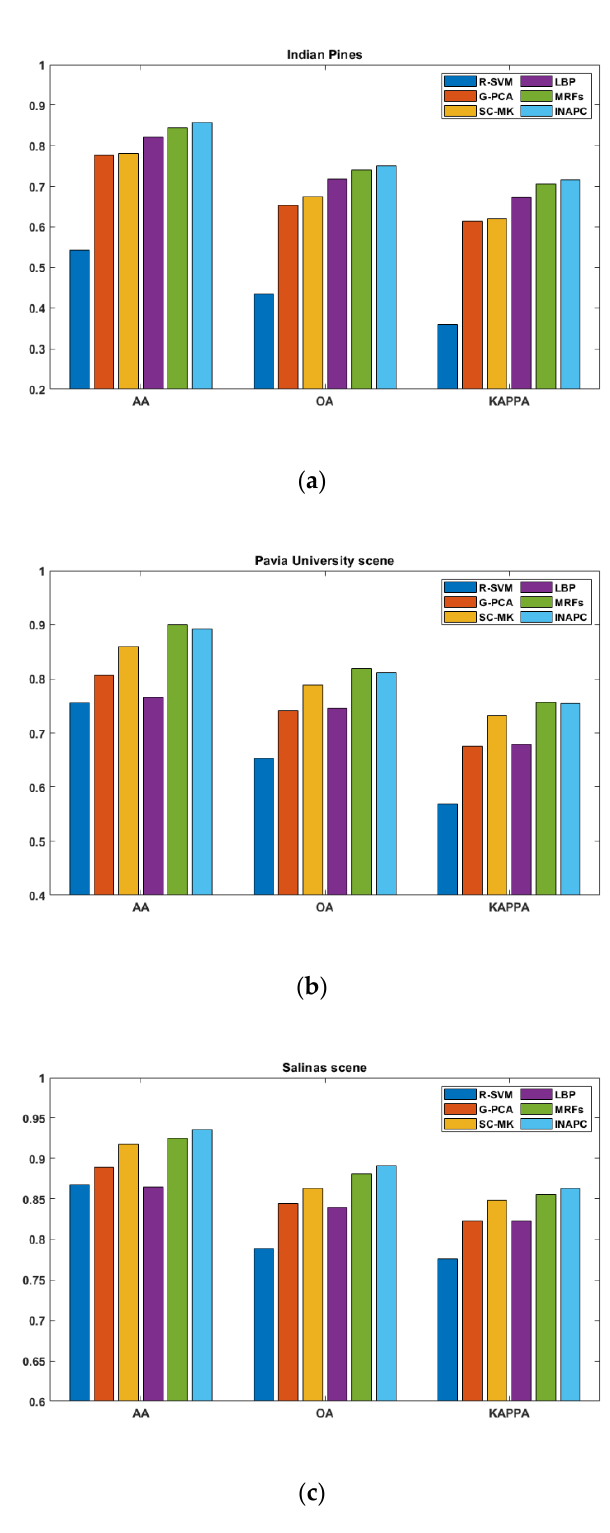
Figure 6. The classification results of ten repeated experiments on the three datasets were obtained by different methods. ( a ) Indian Pines; ( b ) Pavia University scene; ( c ) Salinas scene.